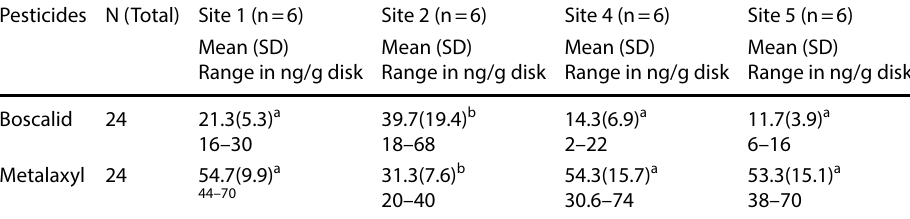
Means of boscalid and metalaxyl that do not have the same letter are significantly different ( p < 0.05) among Sites in lake Ziway *Passive sampler at Site 3 was